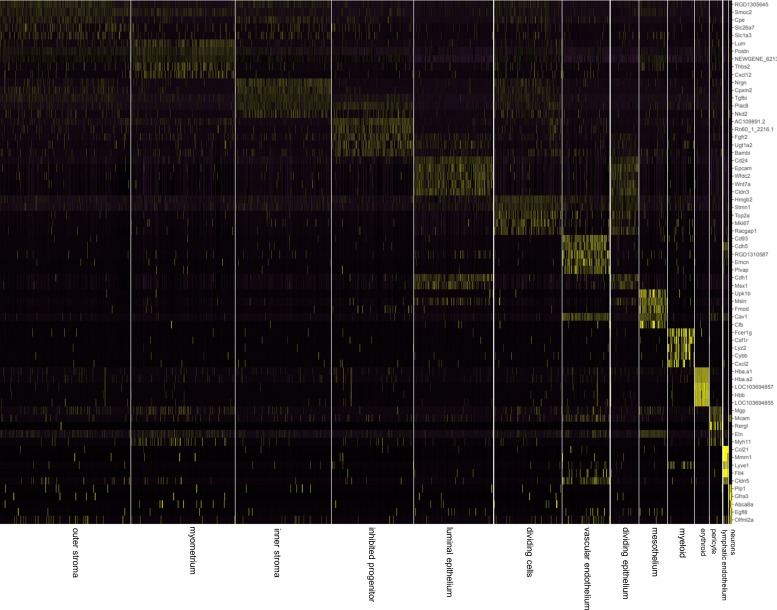
Single-cell RNA-seq reveals the cell atlas of the developing PND6 uterus.Heatmap of top five markers (showing top five genes by fold expression over average) amongst 14 different clusters (Figure 3—source data 1).